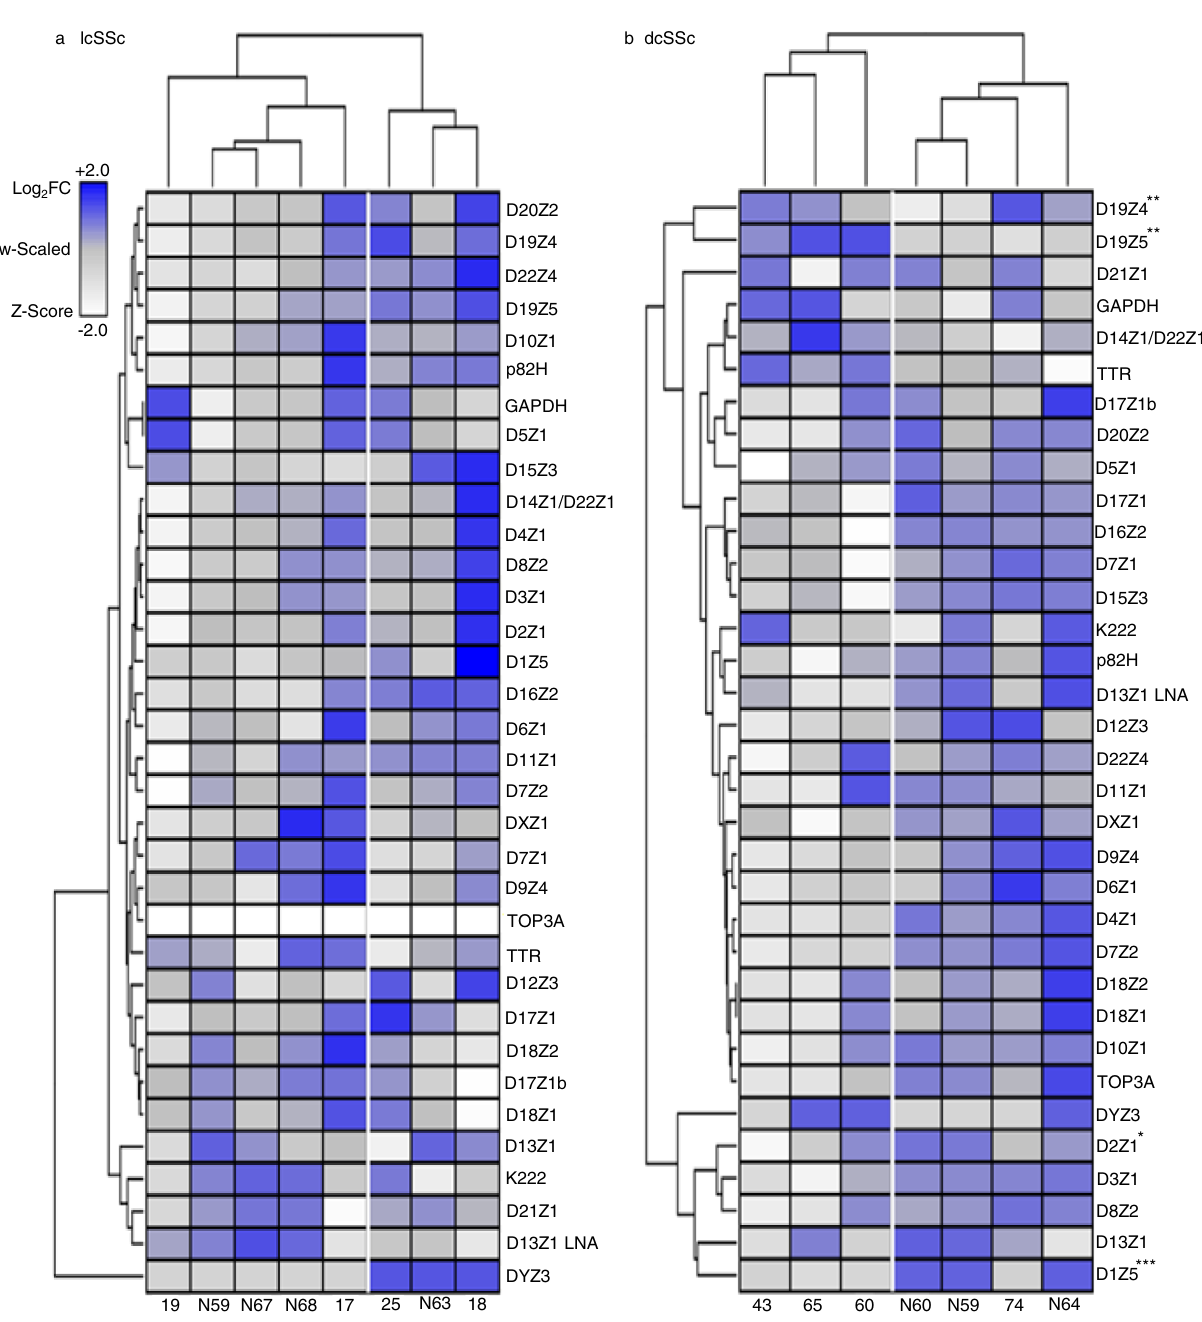
samples (N59, N60, and N64) and show evidence of marked loss of centromere repeats in multiple chromosomes. The color gradient bar represents relative abundance(left).Nosigni fi cantvariationof chromosomalarmgenecopynumbers GAPDH, TTR, and TOP3A were observed. The nomenclature of these α -satellites begins with the letter D, followed by their chromosome number (1 – 22, X or Y), followed by a Z, and a number indicating the order in whichthese sequences were discovered. The DYZ3 repeat accurately represents the gender of the individuals (light gray: female; blue: male). Data obtained in three replicates were analyzed using a multiple unpaired t -test, assuming a gaussian distribution. Stars indicate statisticallysigni fi cantdifferencesbetweenthegroupsina t -testanalysis(* p =<0.5, ** p =< 0.1, *** p =< 0.001). LNA lock nucleic acid. Source Data are provided as a Source Data fi